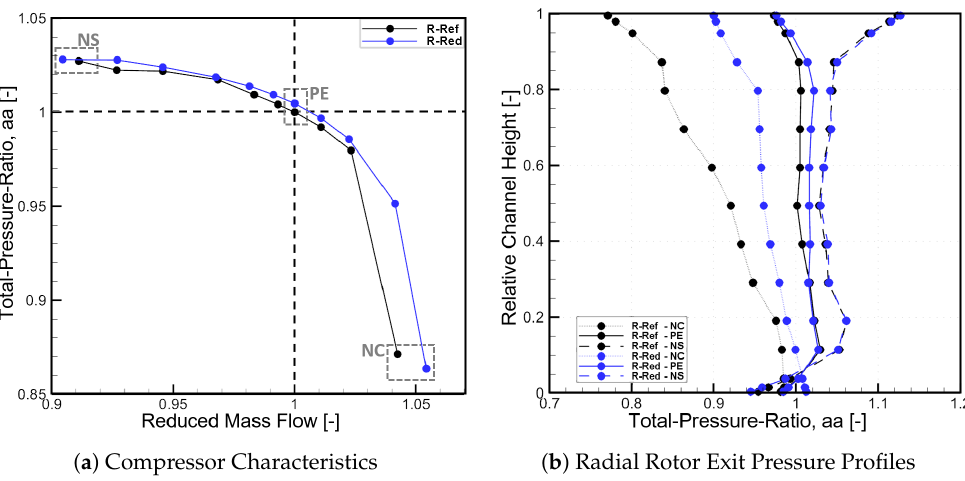
Figure 2. Steady Aerodynamics and Compressor Performance at Design Speed